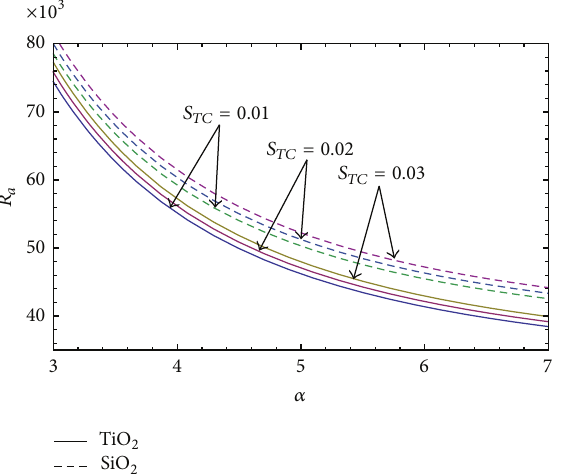
Figure 10: Effect of 𝑆 𝑇𝐶 on semiconducting nanoparticles.